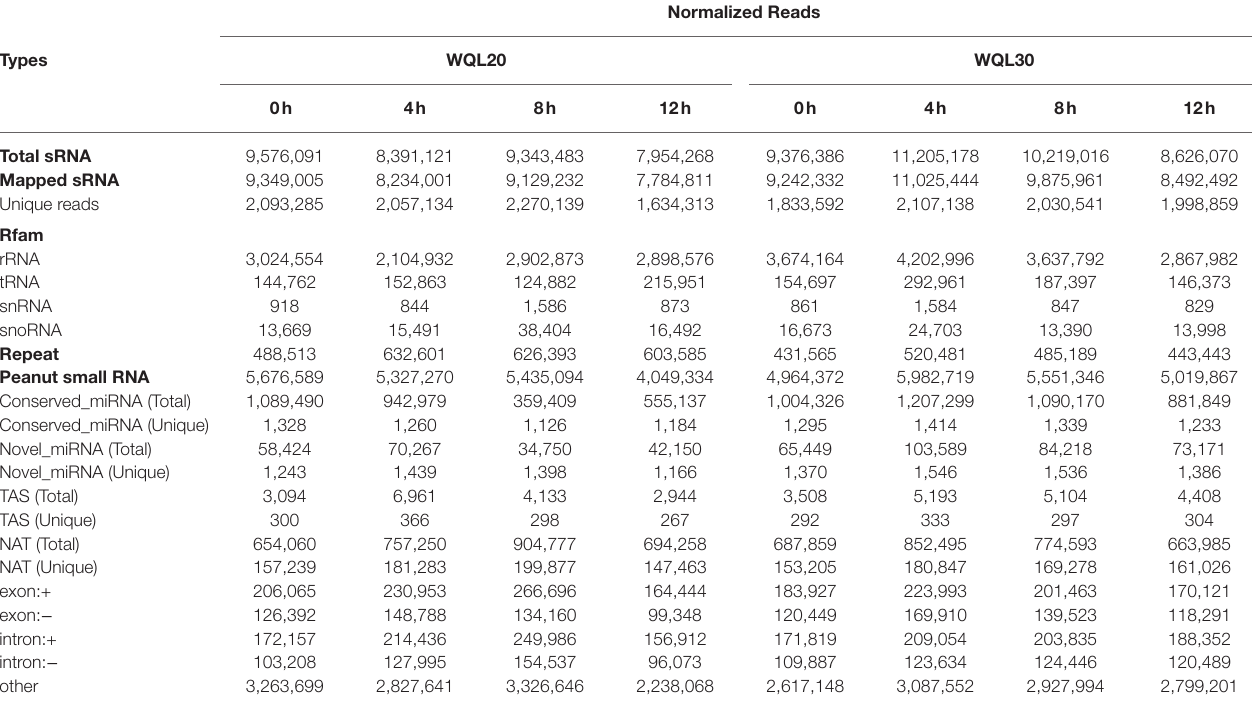
TABLE 1 | Distribution of sRNAs among different categories in each